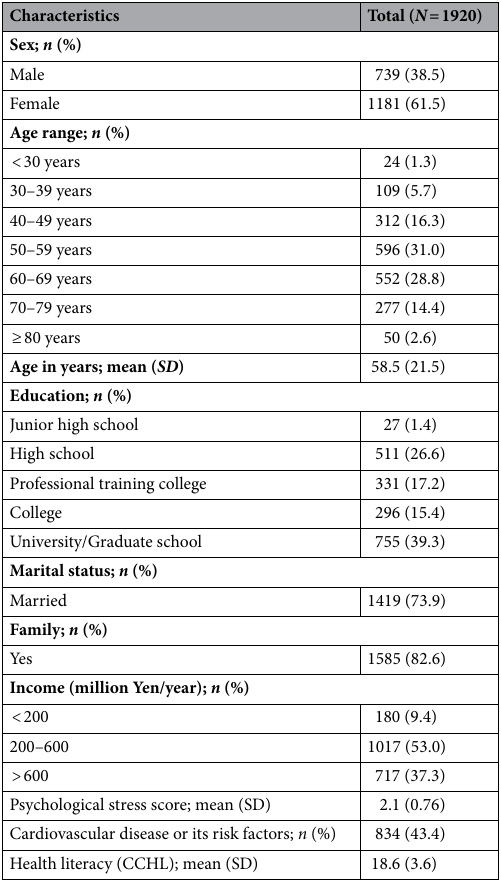
Table 1. Demographic characteristics of the cohort. SD standard deviation, CCHL the communicative and critical health literacy.